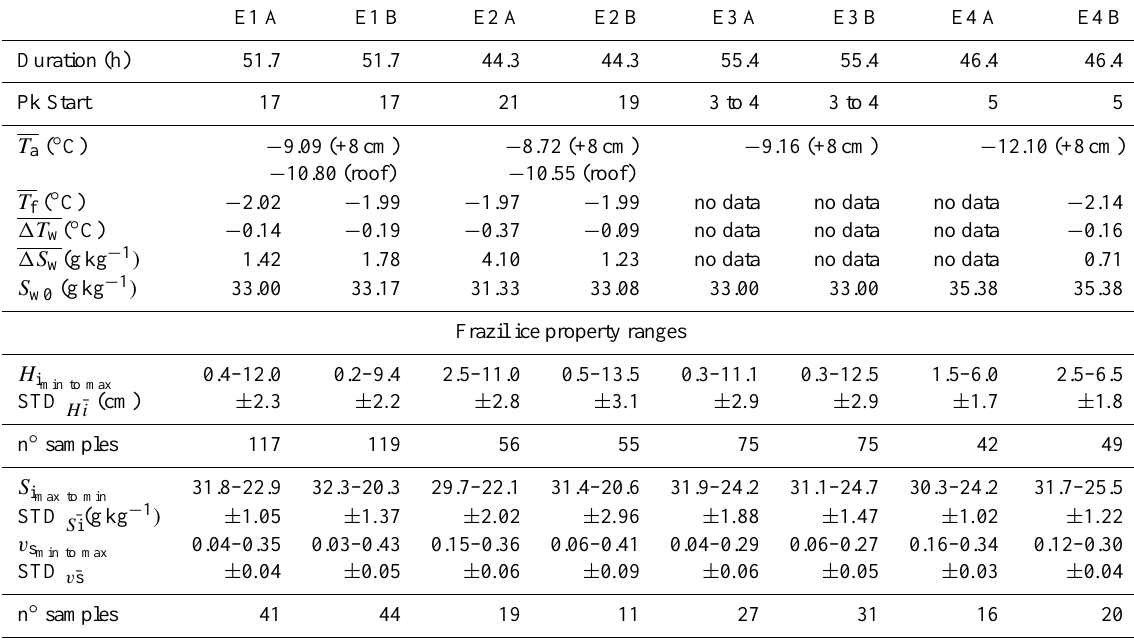
Table 1. Experiment properties. Total experiment duration, Start of pancake formation, T a : mean air temperature from +8cm above calm water tank and roof (where available). T f : mean NaCl solution freezing temperature from top CTD (where available). 1T w and 1S w : mean change in water temperature and water salinity during experiment duration. S w0 : initial salinity before ice freezing, measured for E1 and E2 from top CTD data, calculated for E4 (see Sect. 3.5) and estimated for E3 assuming same conditions as in E1. H i , S i and v s : maxima and minima values for frazil ice thickness, salinity and volume fraction data. STD , STD and STD v s denote the average variation of variables H i S i